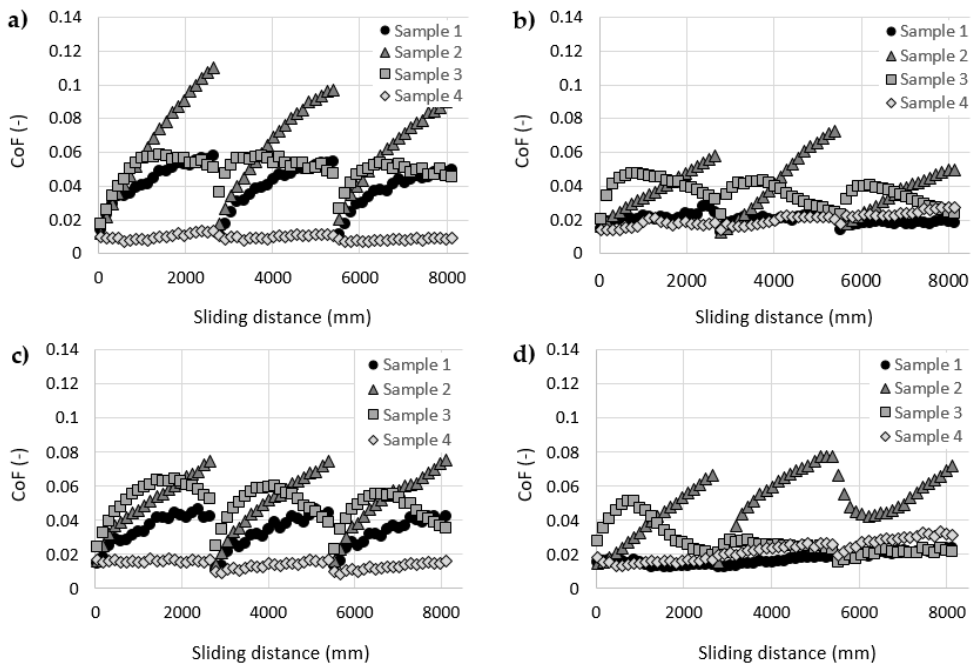
Figure 5. Coefficient of friction as a function of a sliding distance for four cartilage samples and HA solutions with a molecular weight of: ( a ) 77 kDa, ( b ) 640 kDa, ( c ) 1060 kDa, ( d ) 2010 kDa.